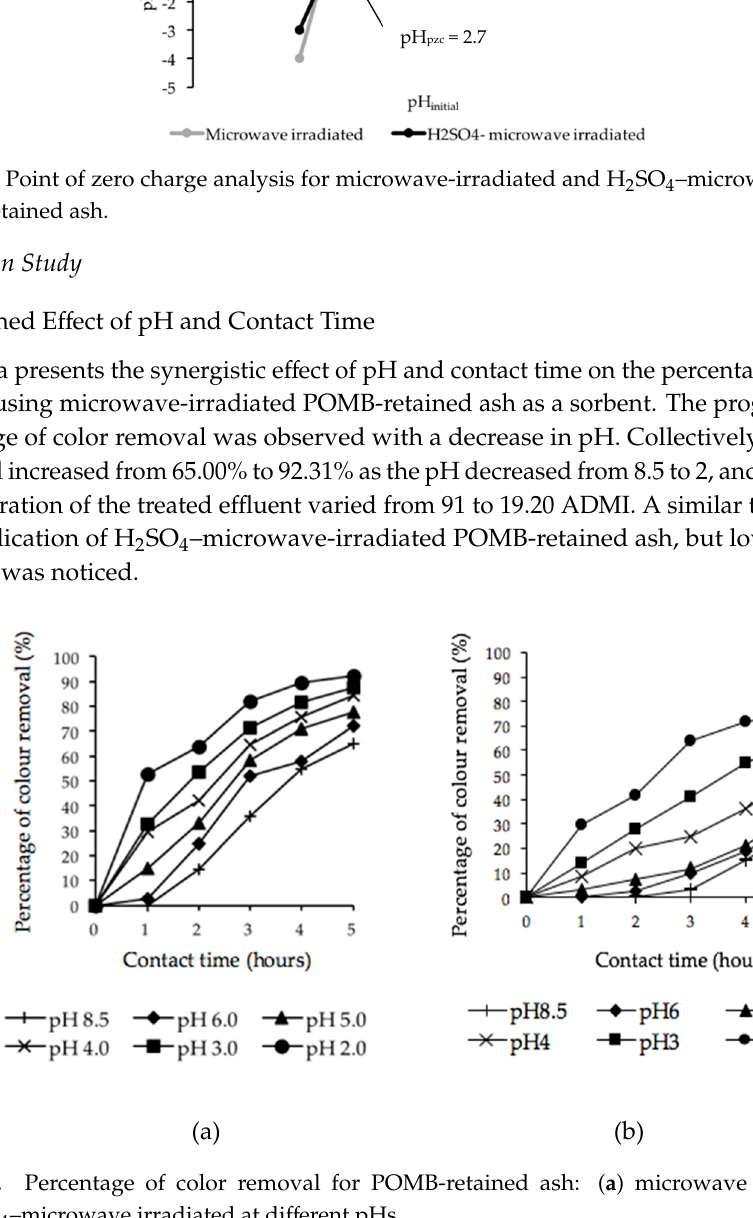
Figure 4. Point of zero charge analysis for microwave-irradiated and H 2 SO 4 –microwave-irradiated POMB-retained ash.